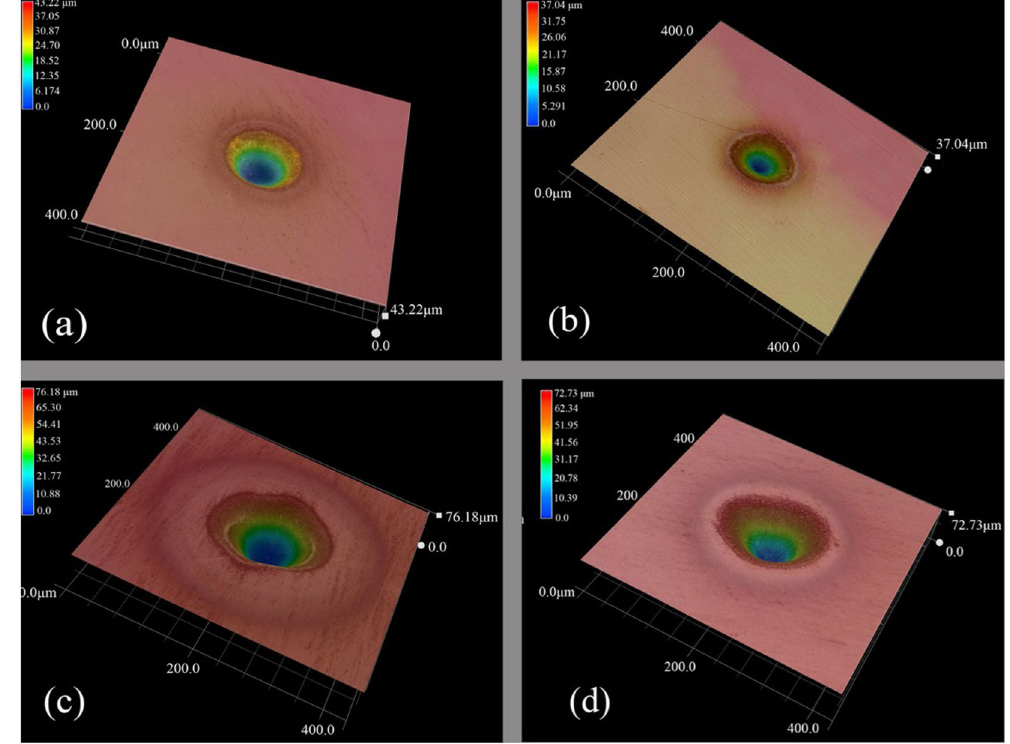
Figure 7. 3D Optical micrographs of laser-induced damage sites after irradiation with average power of 30 mW at 3 μ m: ( a ) As 2 S 3 glasses; ( c ) As 2 Se 3 glasses, and at 4 μ m: ( b ) As 2 S 3 glasses; ( d ) As 2 Se 3 glasses.